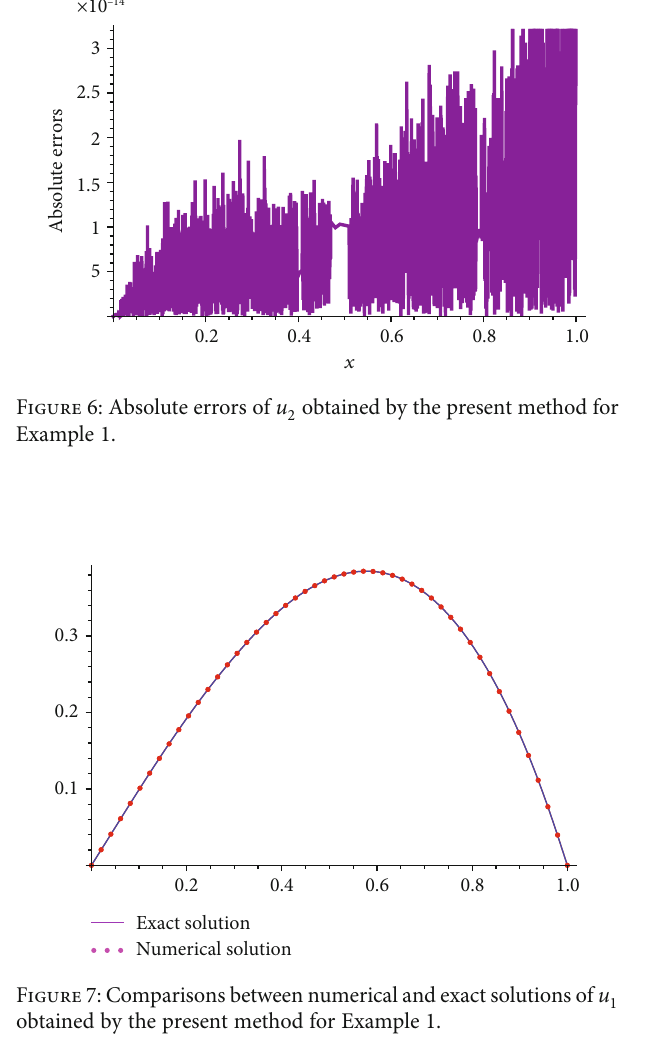
Figure 8: Comparisons between numerical and exact solutions of u obtained by the present method for Example 1.